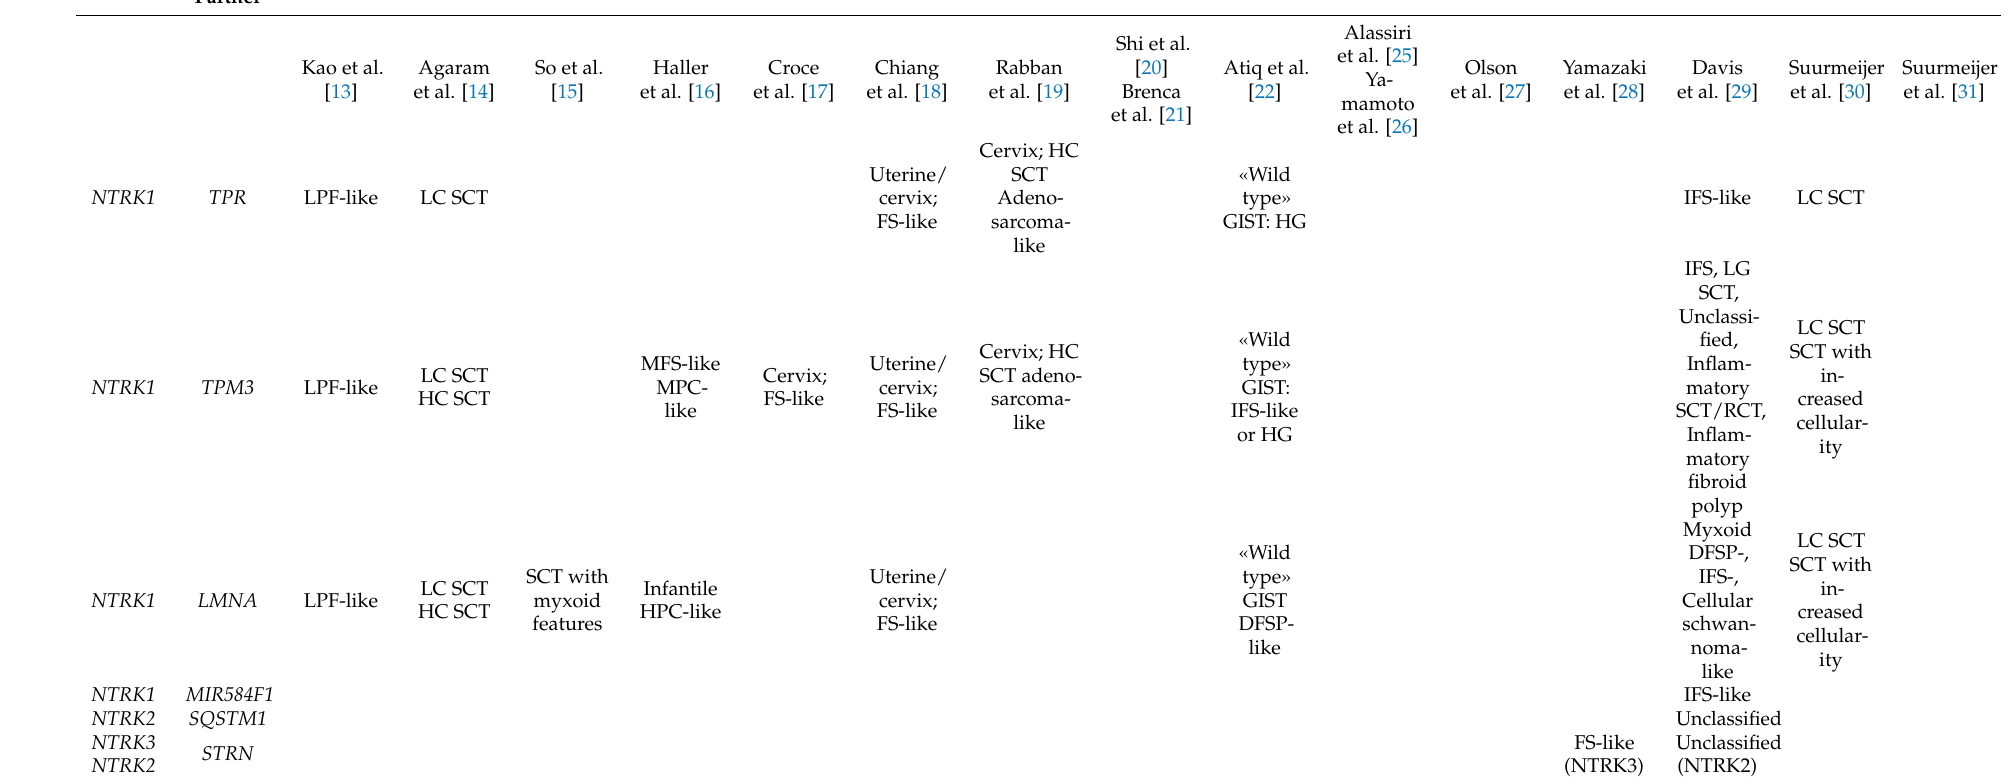
Table 1. Correlation between the different neurotrophic tyrosine receptor kinase genes ( NTRK ) fusions and main histo-morphological features of the soft tissue tumors as described in different